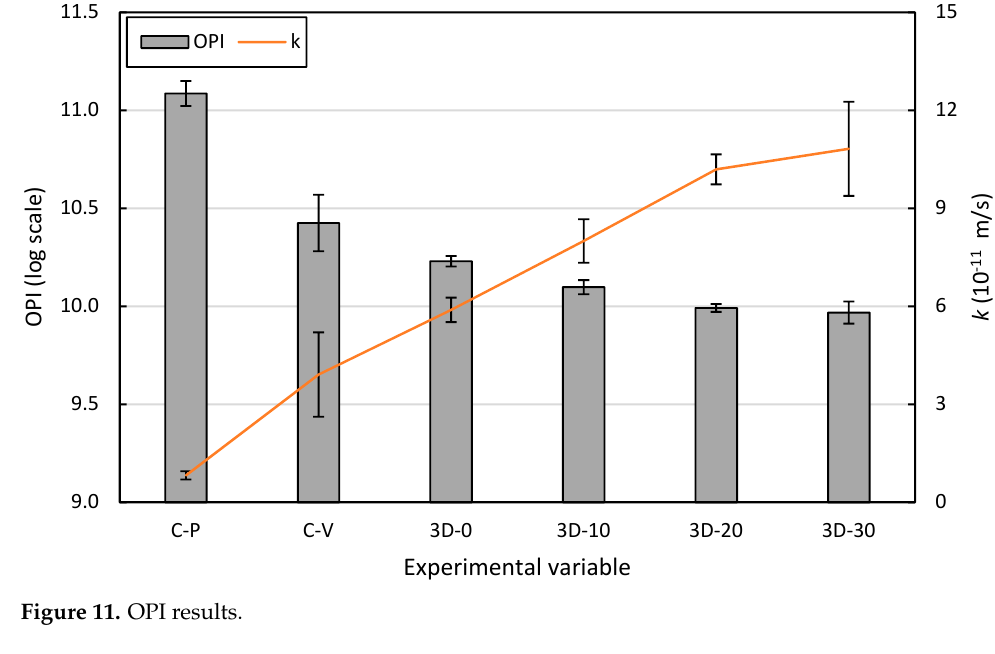
Figure 11. OPI results.